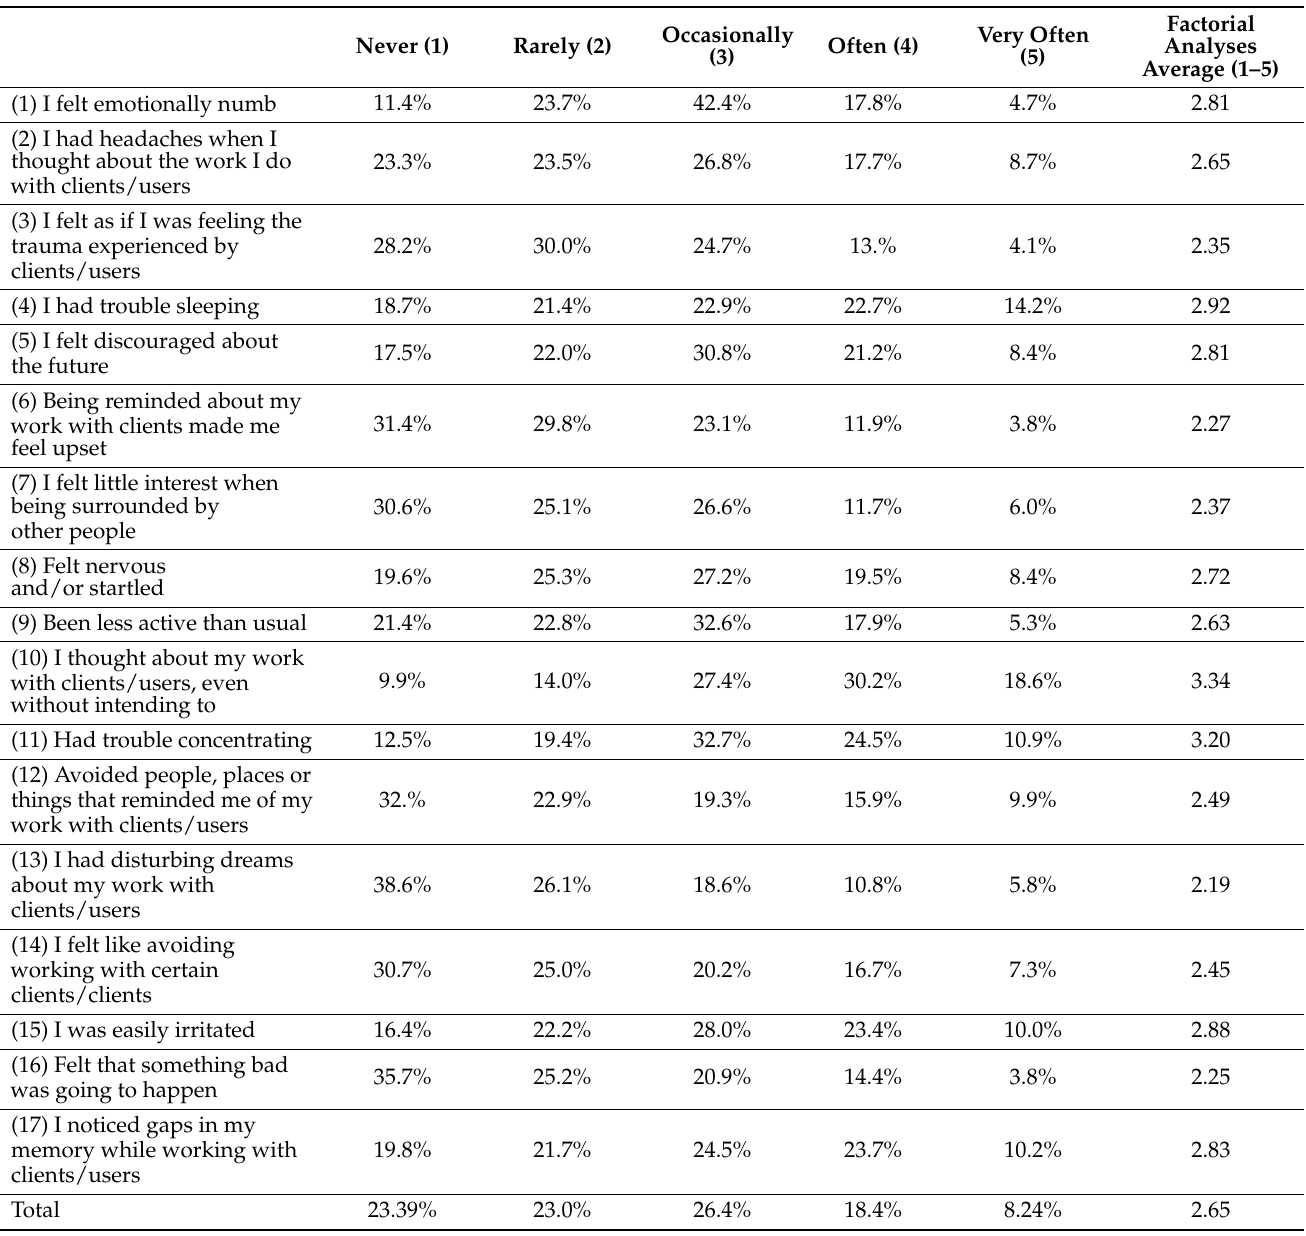
Table 1. Statistics of STS.